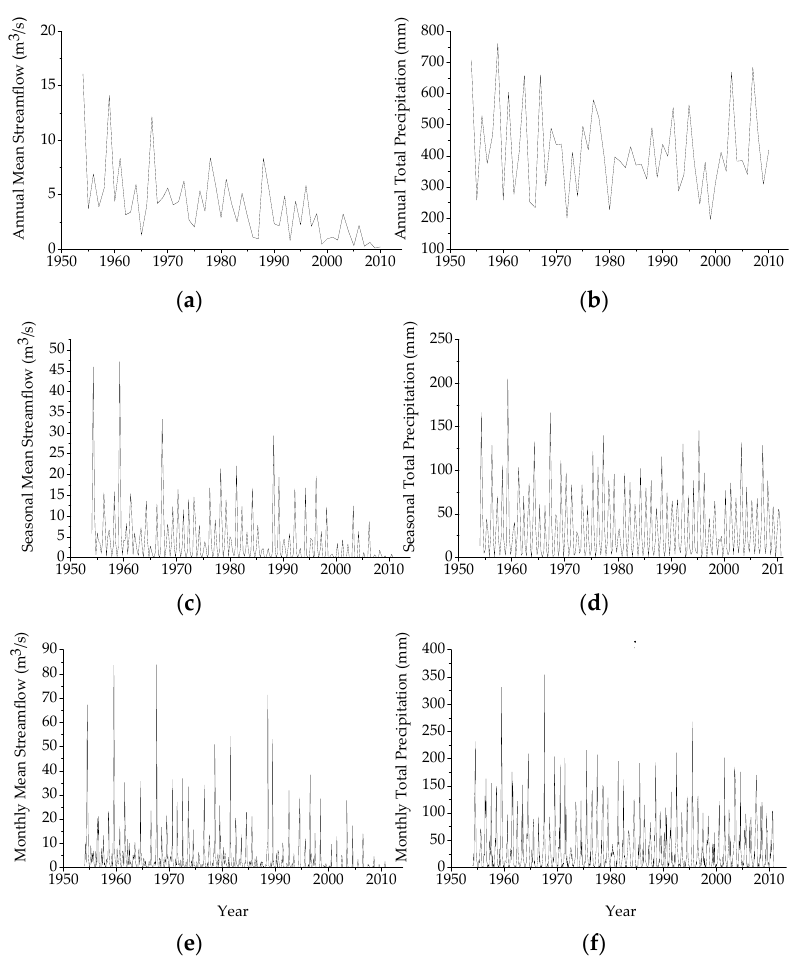
Figure 2. Monthly, seasonal and annual streamflow and precipitation plots of the study used. ( a ) annual streamflow; ( b ) annual precipitation; ( c ) seasonal streamflow; ( d ) seasonal precipitation; ( e ) monthly streamflow; ( f ) monthly precipitation.